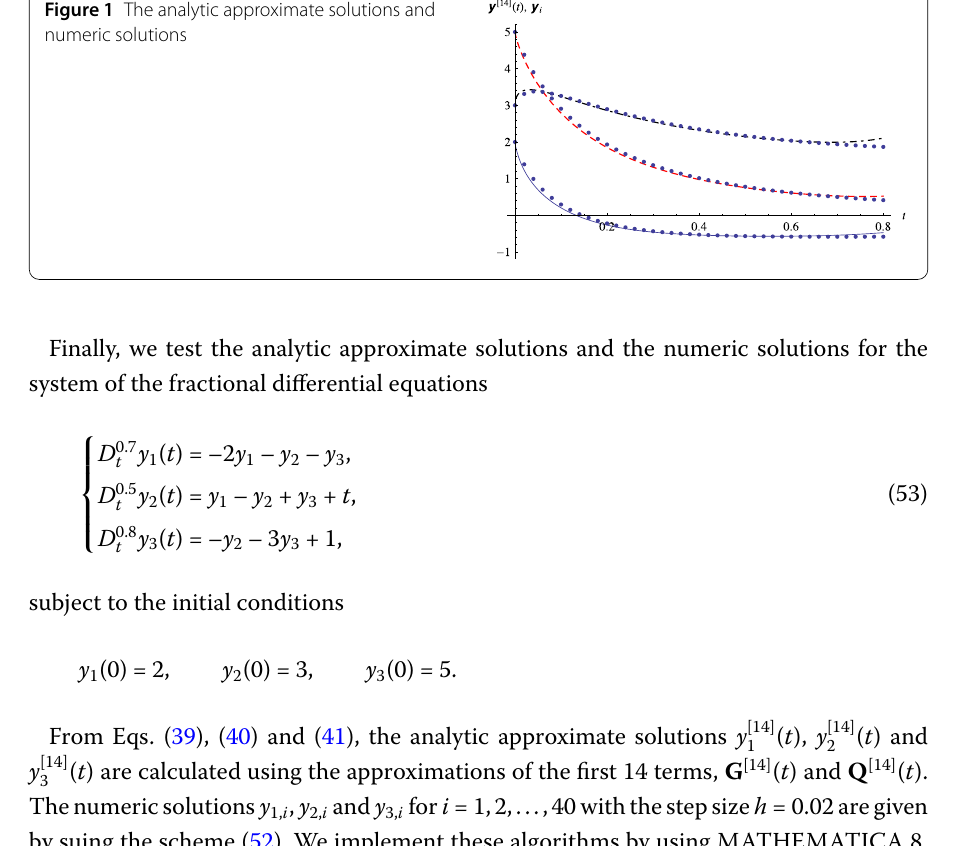
Figure 1 The analytic approximate solutions and numeric